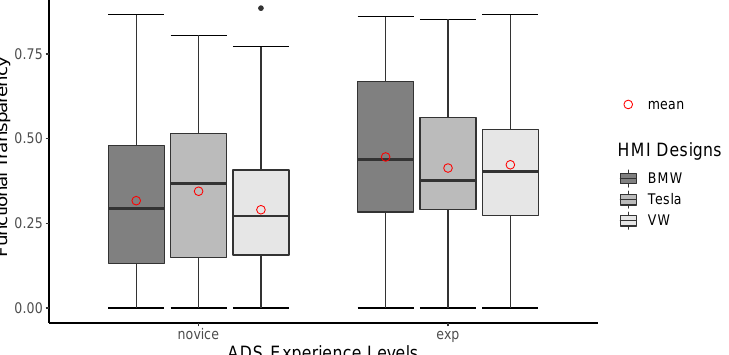
Figure 5. Comparing HMI designs given ADS experience levels (exp stands for experienced in ADS experience